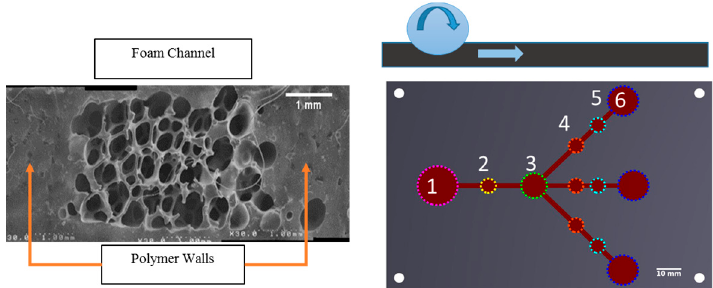
Figure 2. SEM image of a foam channel section. The liquid can flow through the porous matrix soaked in polymer (a). Top view of a fluidic pathway designed for a blood typing test. A rolling actuation induces the transport of biological samples through successive reservoirs (1: buffer; 2: